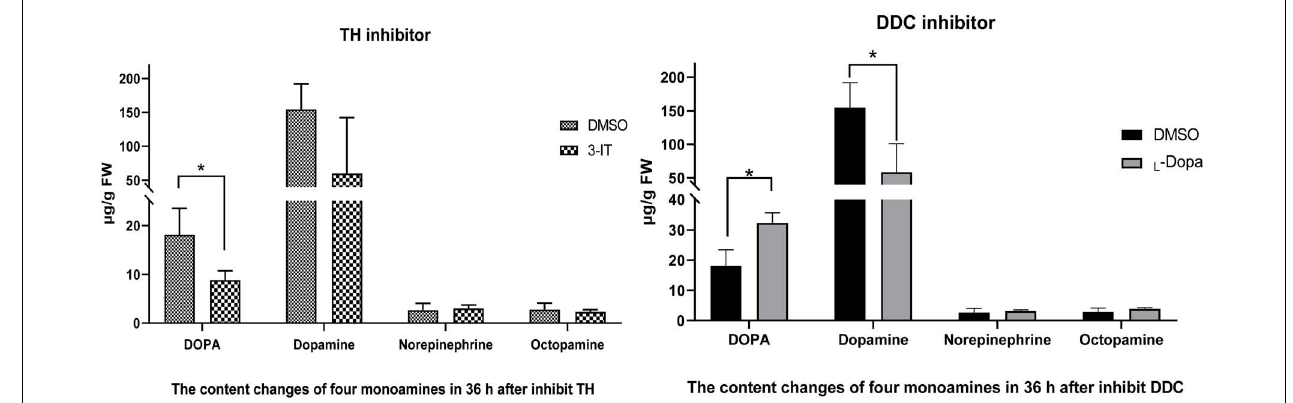
FIGURE 8 | Content changes of four monoamines (including DOPA, Dopamine, Norepinephrine, and Octopamine) after TH and DDC enzyme inhibitors injection. Color changes under different titers of 3-IT and L -DOPA during 12 h. Three replicates were considered; the bar represents mean ± SD ( n = 3), and significant differences were determined using Student’s t -test (* p < 0.05).